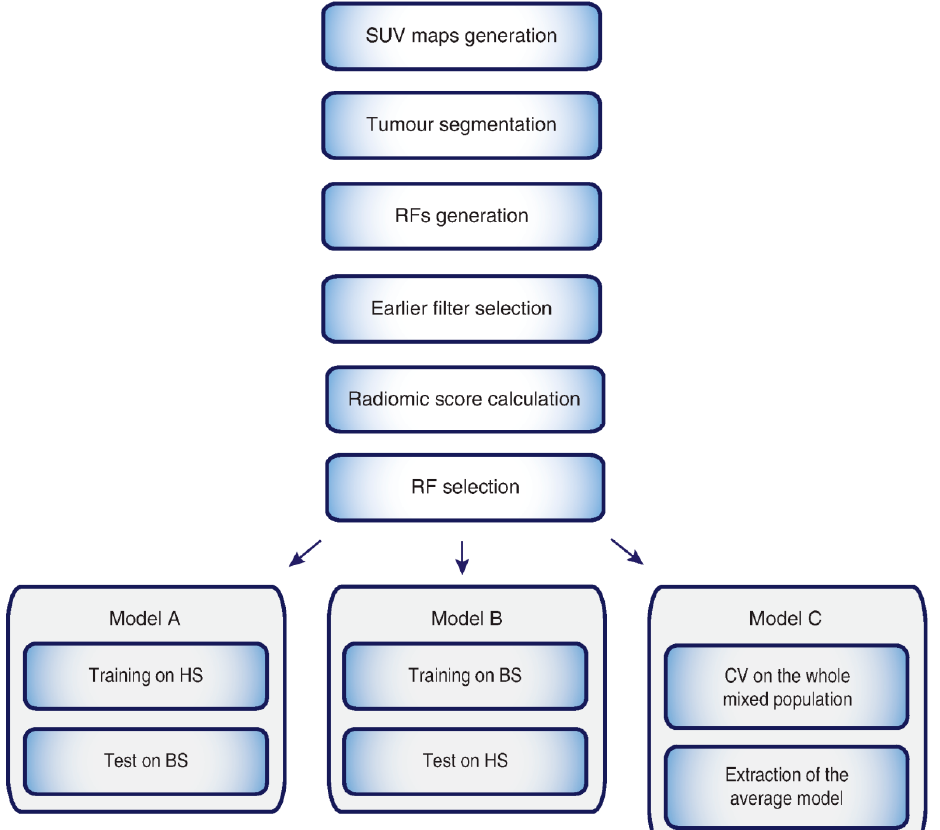
Figure 1. Workflow employed to extract radiomic features (RFs). First, segmentation of the primary lesion was performed on the transaxial PET images, then RFs were generated and extracted. The single and coupled RFs showing the lowest p -values and the highest AUC were selected and employed to develop the three predictive radiomic models used in this study. In model C, cross-validation (CV) on the whole mixed population was performed. Tumour grade was assessed either by histology on the whole excised primary lesion (HS) or on its biopsy